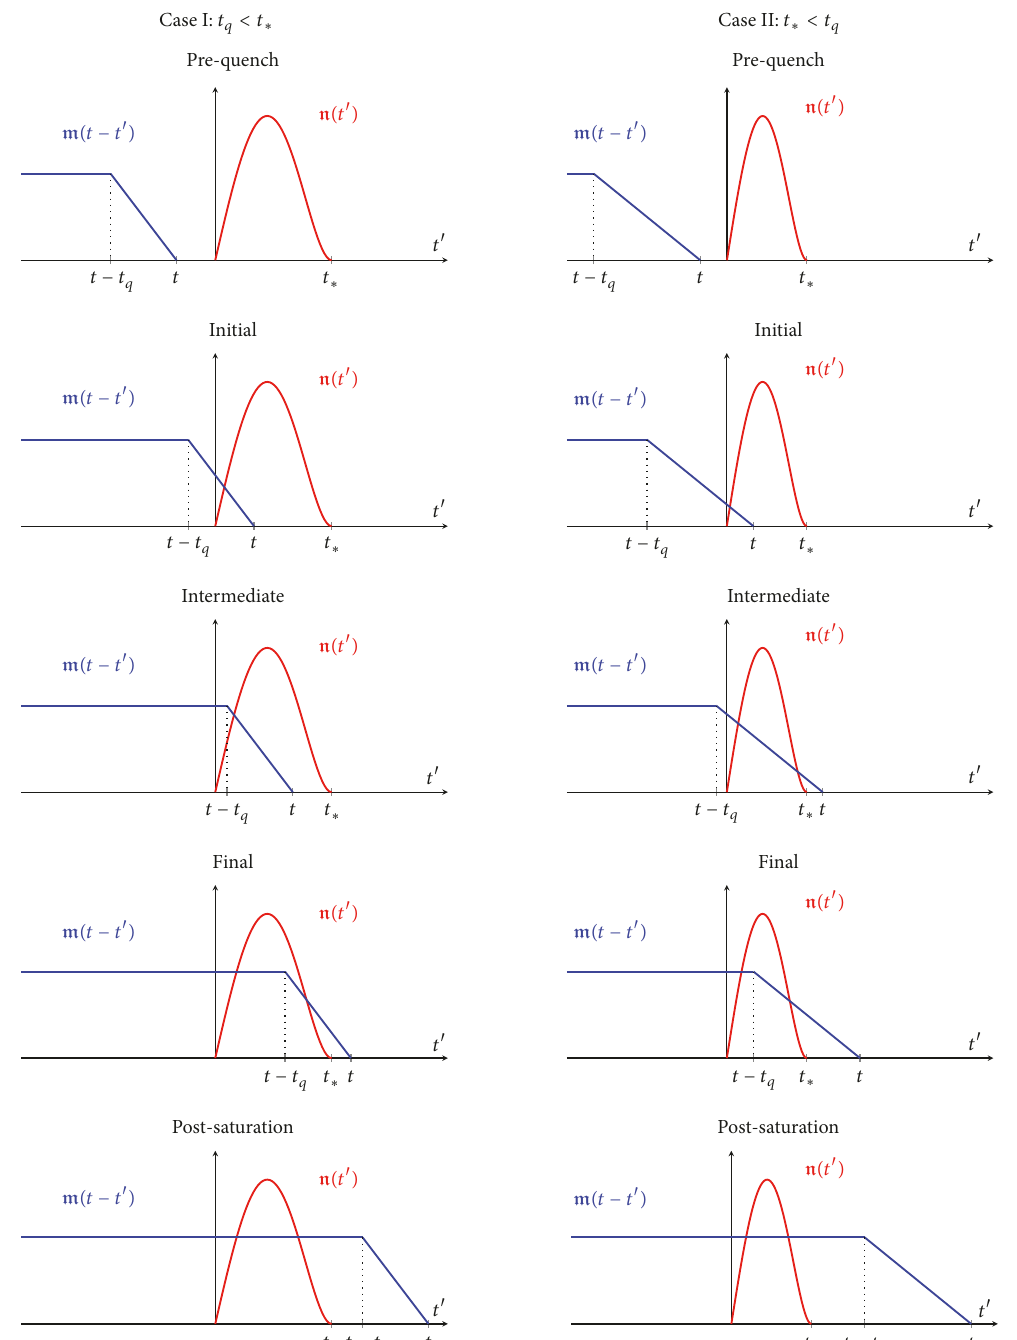
Figure 6: Schematic representation of the convolution integral for a power-law quench with 𝑝 = 1 . The right and left columns show the two possible cases I: 𝑡 𝑞 < 𝑡 ∗ and II: 𝑡 ∗ < 𝑡 𝑞 , respectively. In the pre-quench and post-saturation regimes the integral is a constant. In the initial, intermediate, and final growth regimes the integral is time-dependent and can be performed by splitting it in various intervals, as shown in (112) and